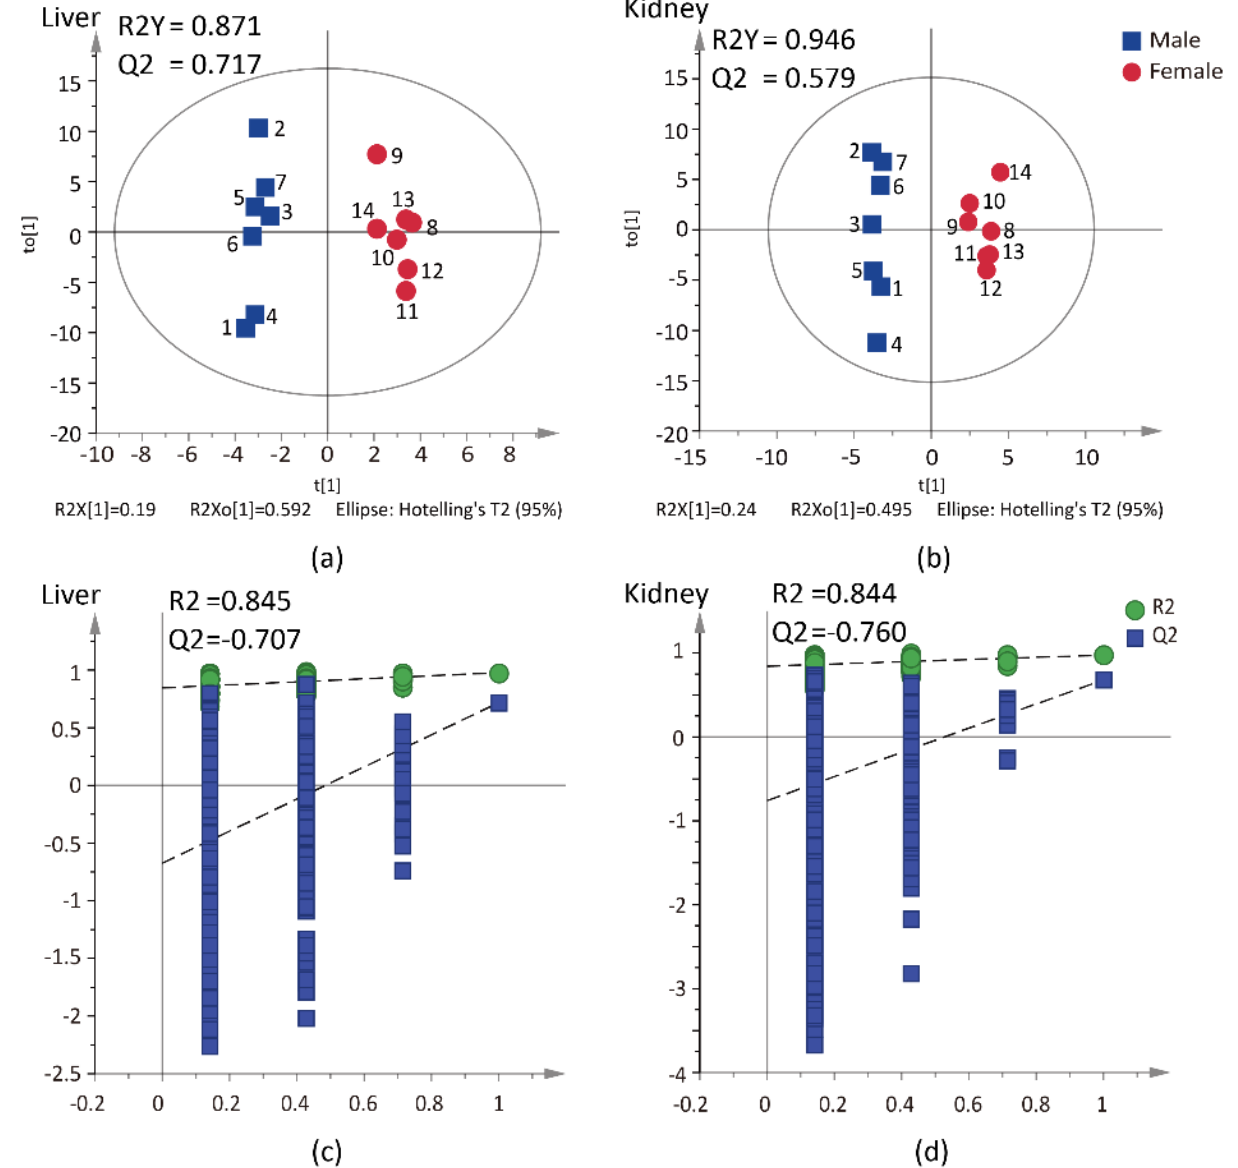
Figure 4. The results of OPLS-DA models and 999 permutation tests based on male and female in liver and kidney tissues. ( a ) The score plots from OPLS-DA model of liver. ( b ) The score plots from OPLS-DA model of kidney. ( c ) The validation plots from 999-permutation test of liver. ( d ) The validation plots from 999-permutation test of kidney. Table 2. The PCA-X mode, OPLS-DA mode, and 999-permutation were used for multivariate ex- ploration of clusters and trends among two groups of male and female in seven tissues.